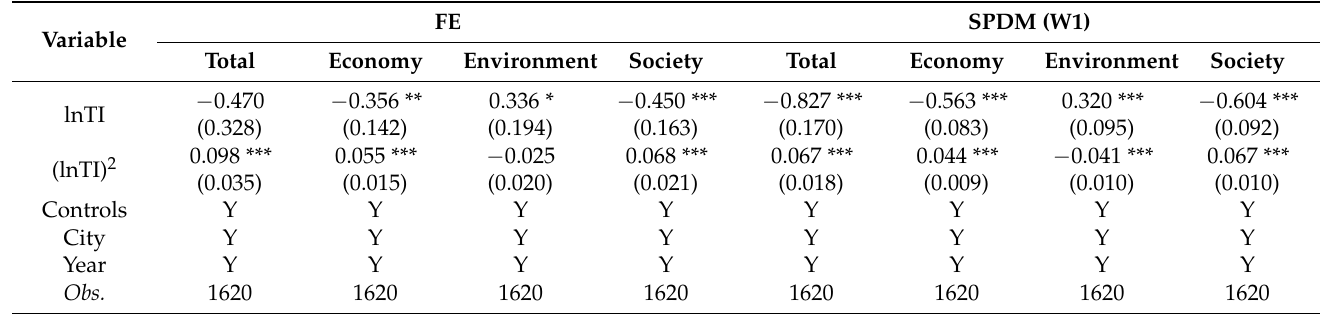
Table A2. Overall regression results (Y = Invention patent